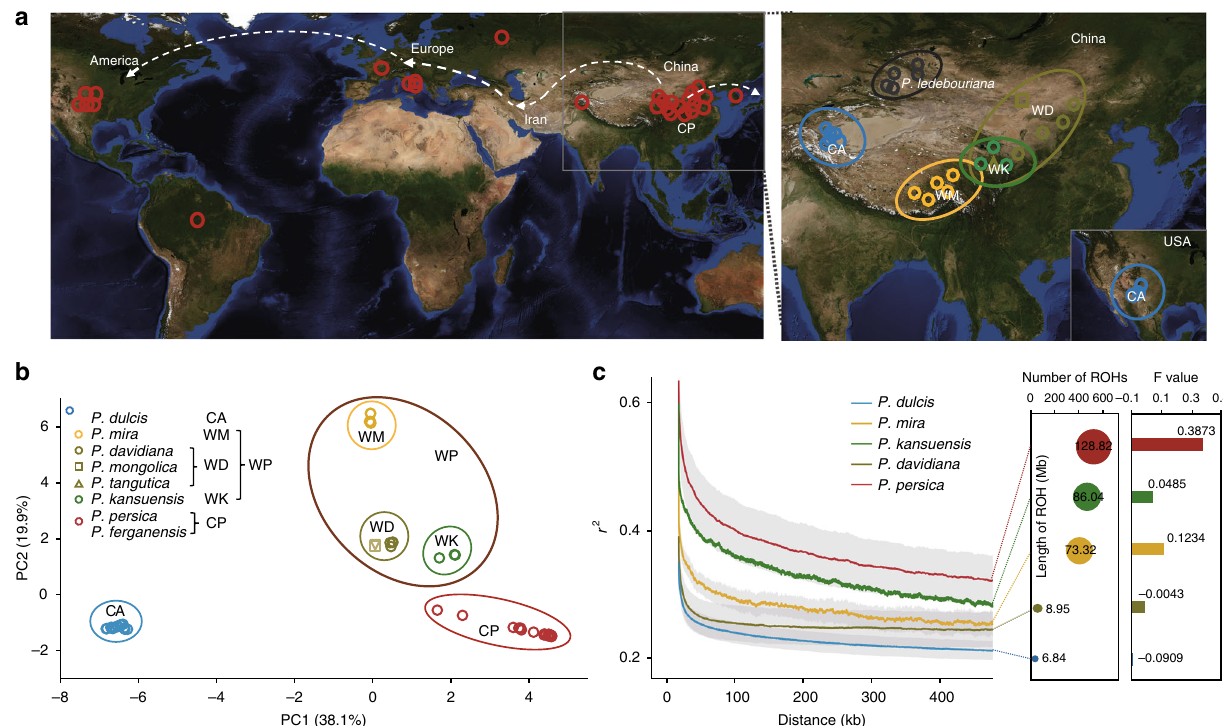
Fig. 1 Genetic divergence of cultivated and wild relative peach, and cultivated almond. a Geographic distributions of the Amygdalus accessions altogether with P. ledebouriana . The CP group includes 22 P. persica and P. ferganensis accessions (left); the WP group includes 29 WM ( P. mira ), WD ( P. davidiana , P. davidiana var. potanini, P. tangutica , and P. mongolica ), and WK ( P. kansuensis ) accessions; the CA group includes 15 P. dulcis accessions, as well as 5 P. ledebouriana accessions (right). The locations of all the accessions are shown with colored symbols corresponding to Fig. 1b. The dispersal route of domesticated peach was shown with white dotted lines. The topographic map was obtained from NASA.gov. b PCA plots of the fi rst two principal components using a total of 2,559,589 whole-genome SNPs (maf<5%, call rate>90%). The fi rst two principal components PC1 and PC2 differentiated the CA accessions from the CP accessions and the WP accessions, and clustered the peaches into four groupings: CP, WK, WD, and WM. c Linkage disequilibrium patterns of fi ve typical species: P. persica , P. kansuensis , P. davidiana , P. mira , and P. dulcis based on the SNPs from the accessions sequenced in this study and data downloaded from Verde et al. 10 and Cao et al. 8 (Supplementary Data 1). Patterns of ROHs (total number, and length indicated by circled areas) and F values of the fi ve species are